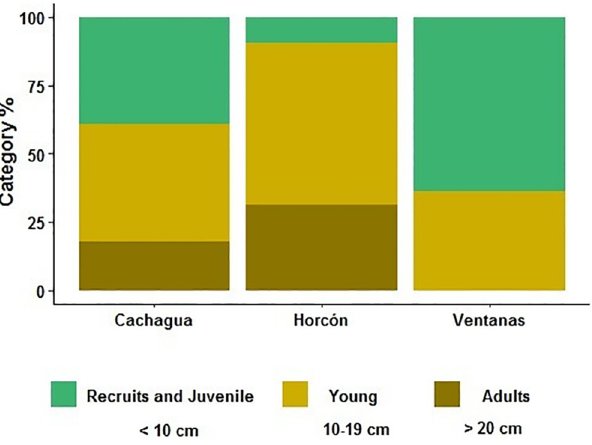
Fig 3. Comparison of size structure based on holdfast diameter. Percentual presence of three categories: recruit and juvenile, young, and adult sporophyte of Lessonia spicata populations. Each bar corresponds to one of the locations in this study: Cachagua, Horco´n and Ventanas.